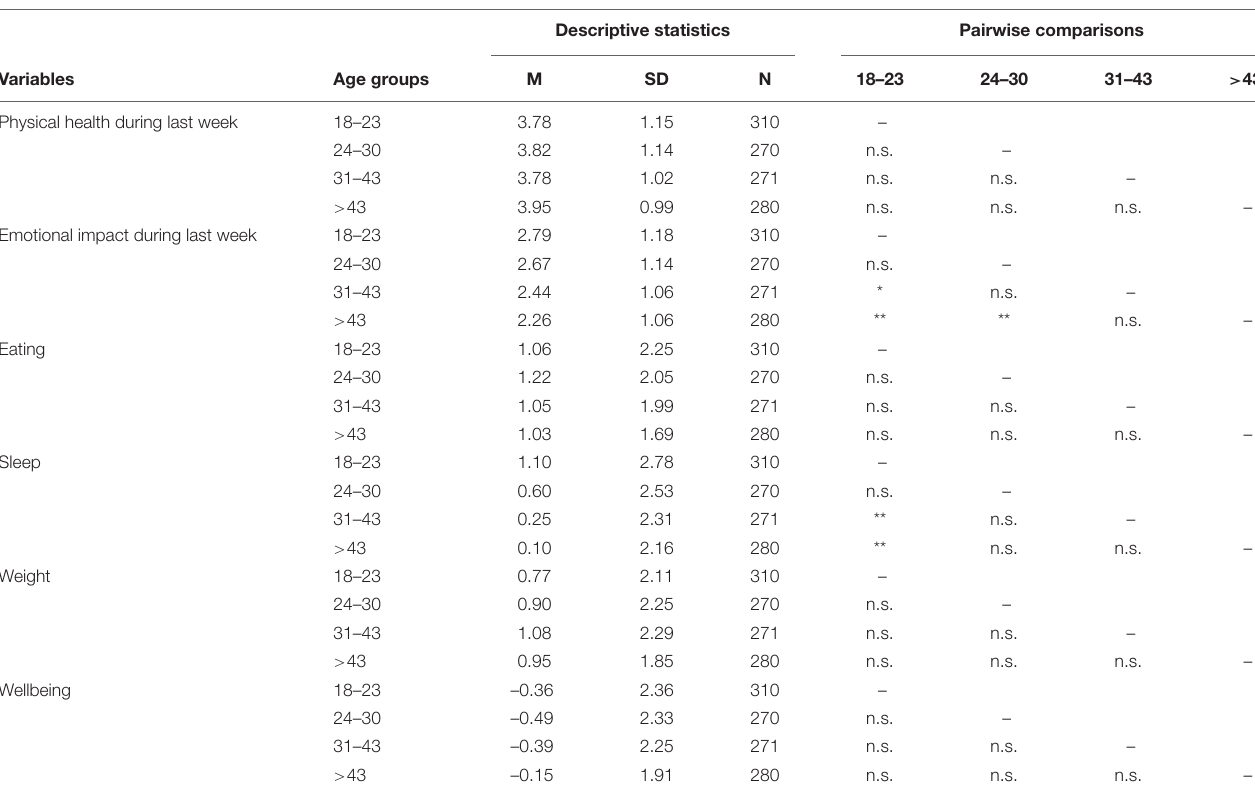
TABLE 3 | Descriptive statistics and pairwise comparisons across age